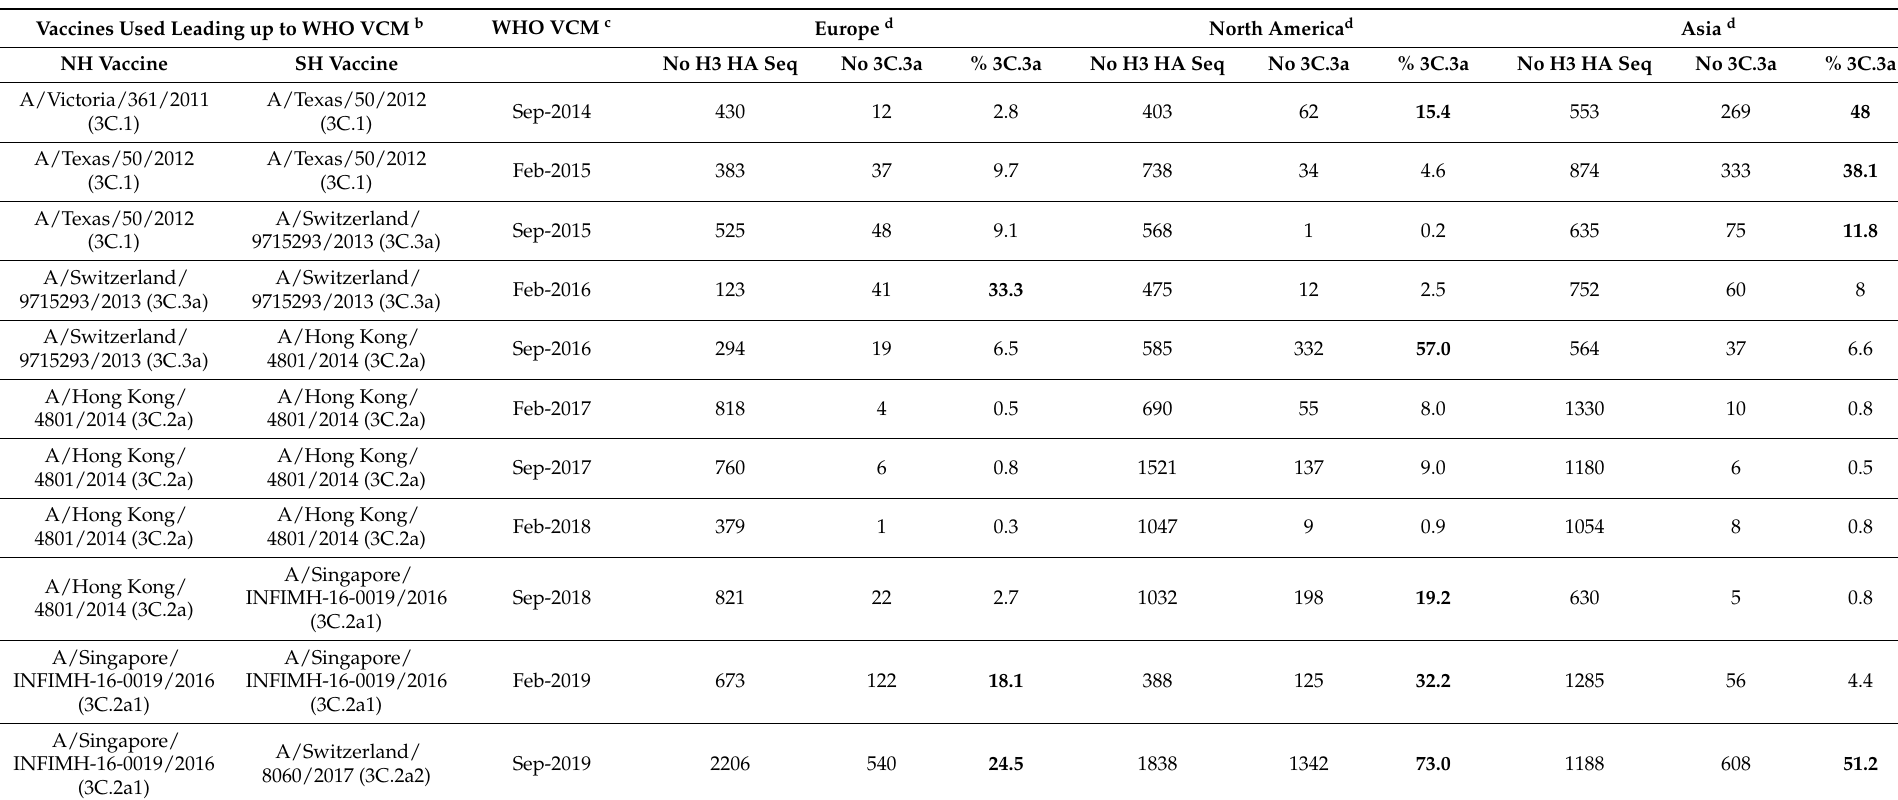
Table 1. Circulation of A(H3N2) clade-3C.3a viruses over periods considered at the times of each WHO Vaccine Consultation Meeting (VCM) a